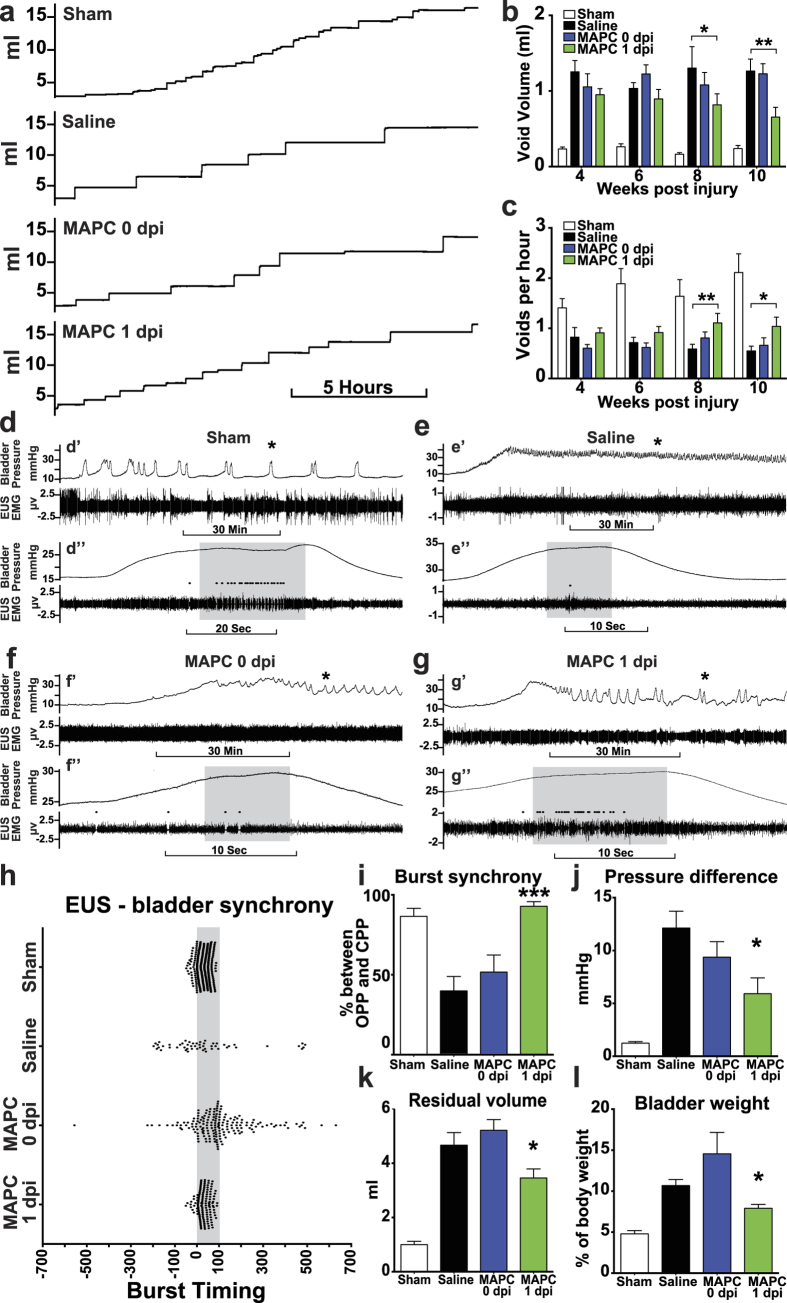
MAPC treatment one day post injury improves micturition pattern and lower urinary tract coordination.(a) Representative smoothed metabolic cage traces 10 weeks after injury of a Sham, Saline treated, MAPC 0 dpi treated, and MAPC 1 dpi treated animals. (b,c) Metabolic cage quantification of average void frequency and void volume. n = 6 Sham, 8 Saline, 9 MAPC 0 dpi, and 8 MAPC 1 dpi. *p < 0.05, **p < 0.01 when compared to Saline treated. Two-way repeated measures ANOVA, Fisher’s Least Significant Difference post-hoc test. (d–g) Representative urodynamic recordings at 10 weeks after SCI. (d’–g’) Compressed view of bladder pressure (top trace) and EUS EMG activity recordings (bottom trace). Asterisks mark expanded void shown below. (d”–g”) Expanded time points from d’–g’. Grey box denotes the time between OPP and CPP. Black dots denote EUS bursting. (h) Scatter plot of EUS bursting over three void cycles in relation to bladder contractions. Grey box denotes the time interval between OPP and CPP (0%–100%). (i) Percentage of EUS bursts between OPP and CPP of bladder contractions. (j) Average bladder pressure difference from baseline to post void. (k) Average residual bladder volume following a void. (l) Bladder weight 10 weeks post injury. n = 5–6 Sham, 8 Saline, 9 MAPC 0 dpi, 8 MAPC 1 dpi. *p < 0.05, ***p < 0.001 when compared to Saline treated. One-way ANOVA, Fisher’s Least Significant Difference post-hoc test. Data represent mean and s.e.m.